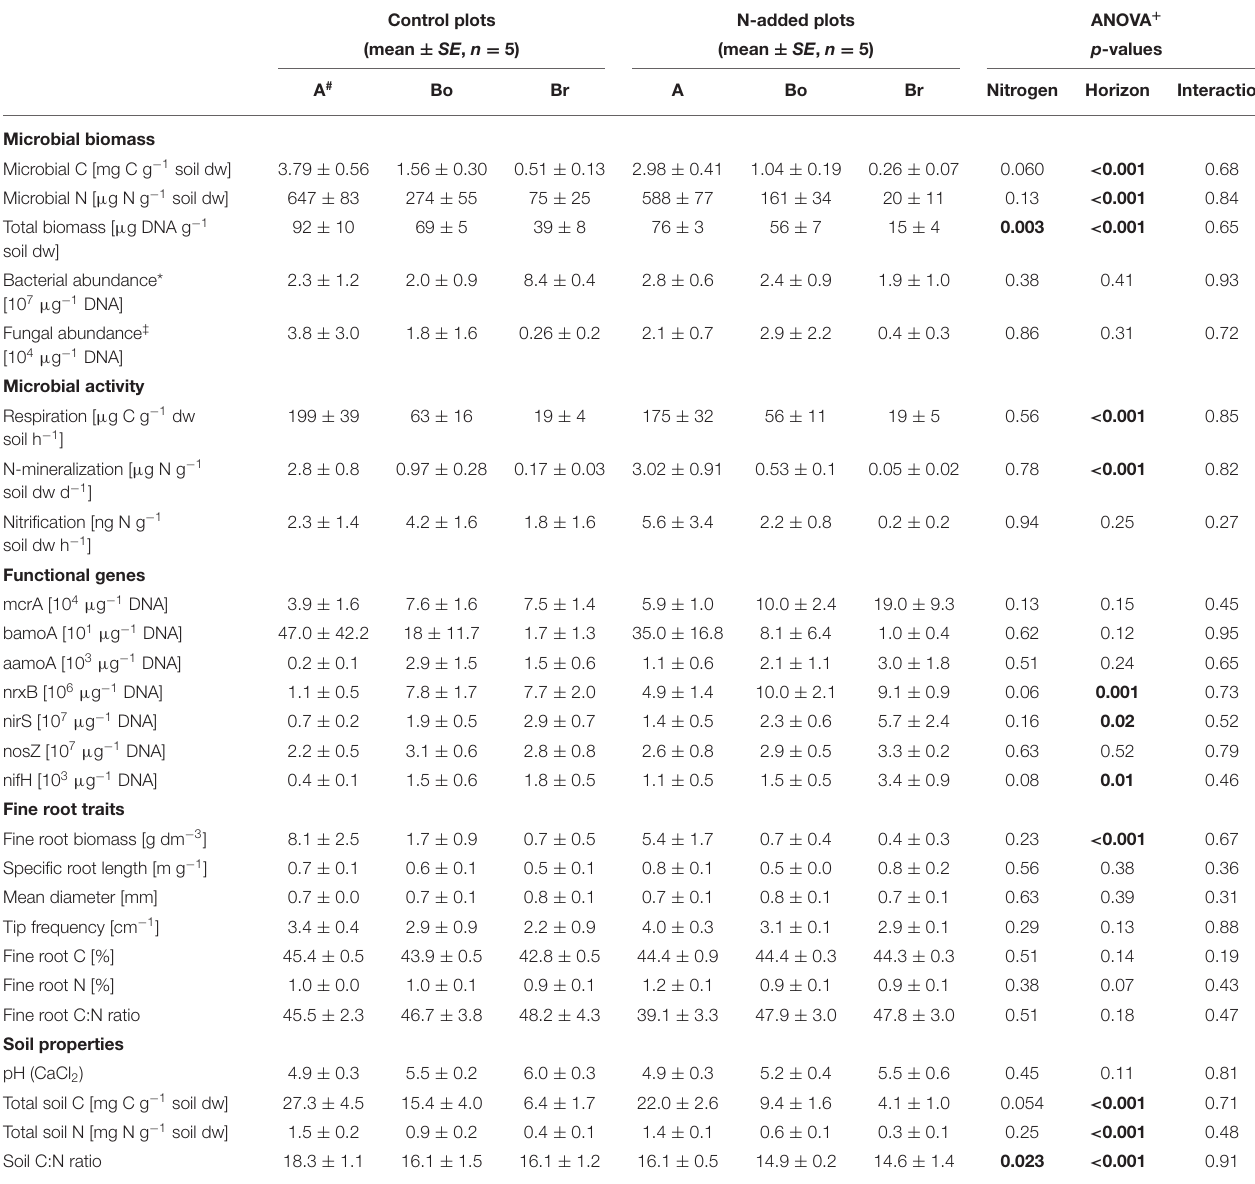
TABLE 1 | Biotic and abiotic site characteristics of soil horizons (A, Bo, Br) in the control and N-added plots of the Alptal N addition experiment. Control plots N-added plots ANOVA + (mean ± SE , n = 5) (mean ± SE , n = 5) p -values Bo Bo Nitrogen Horizon